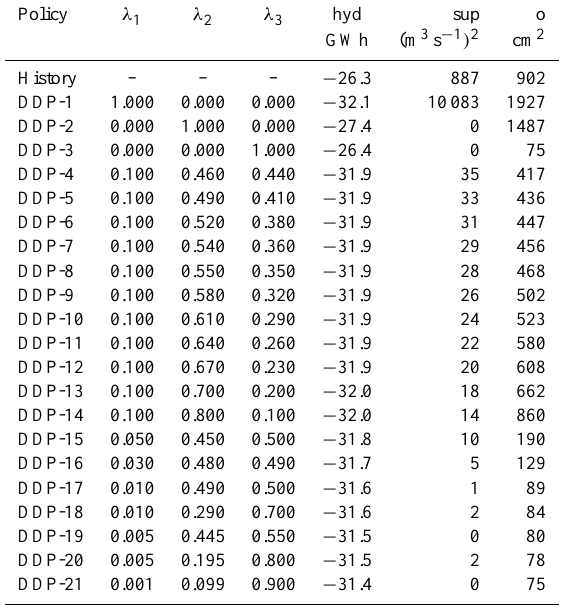
Table 3. DDP results: average value of the immediate costs under different weight combinations (evaluation horizon